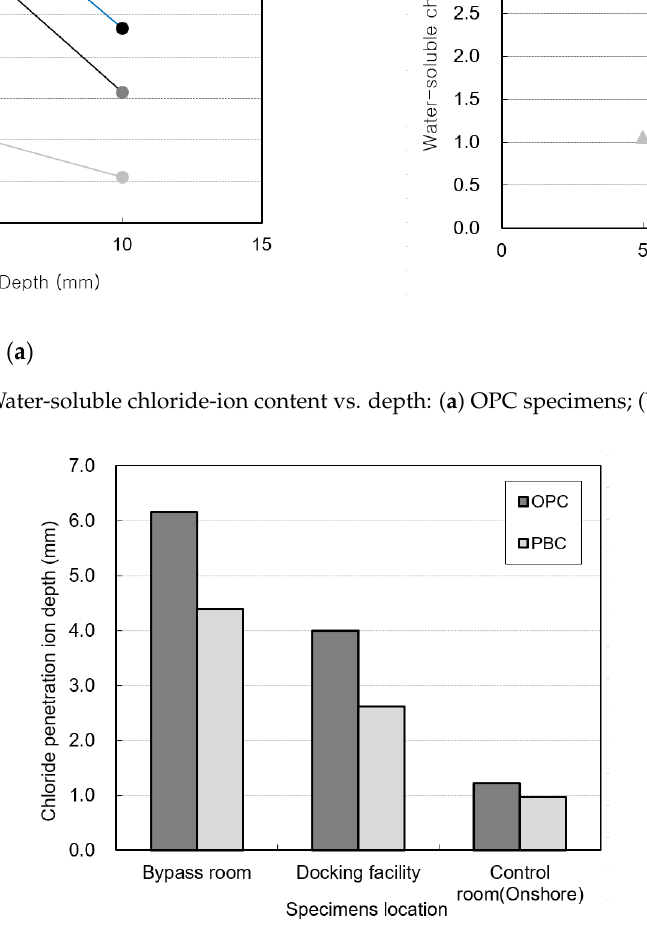
Figure 12. Chloride-ion penetration depth at different exposure locations.